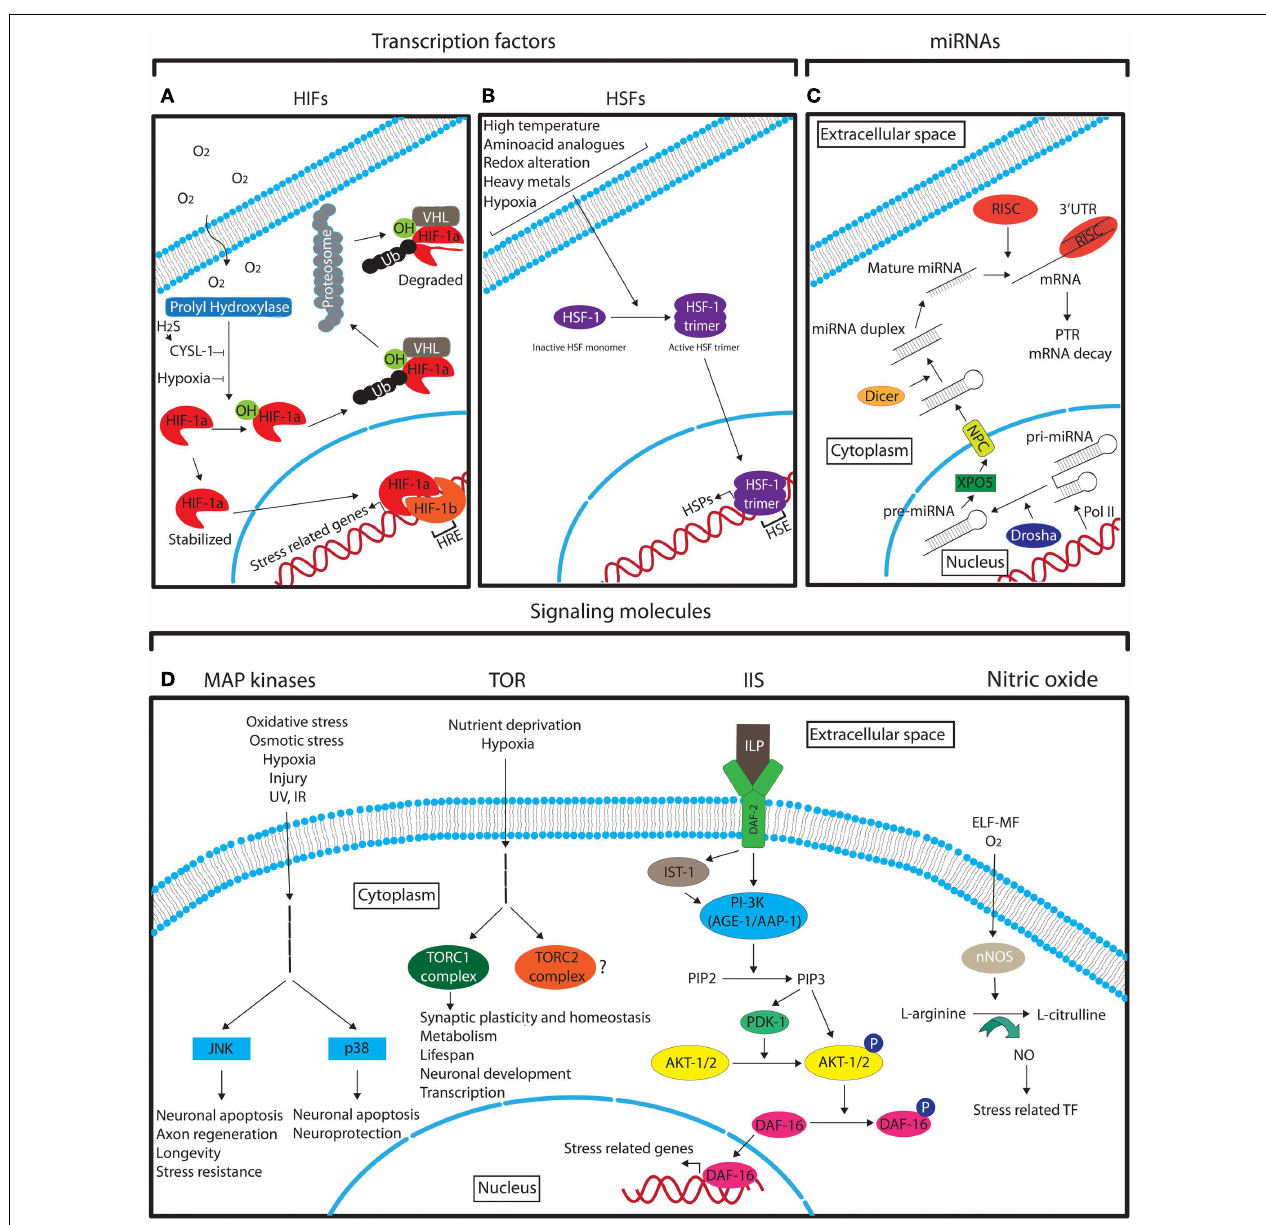
signaling pathways that mediate the neuronal response to different stresses. Legend: arrows indicate the pathway flow and/or the positive effect of an element onto another. Blunted arrows indicate inhibition. Question mark denotes lack of information. Ub, ubiquitin;TF, transcription